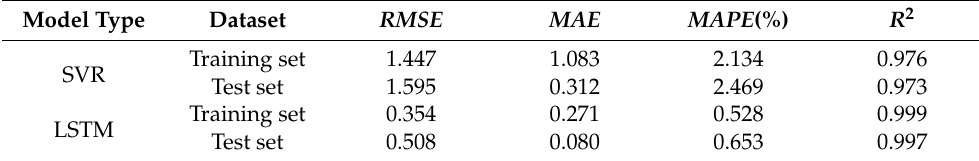
Table 2. Performance comparison of two